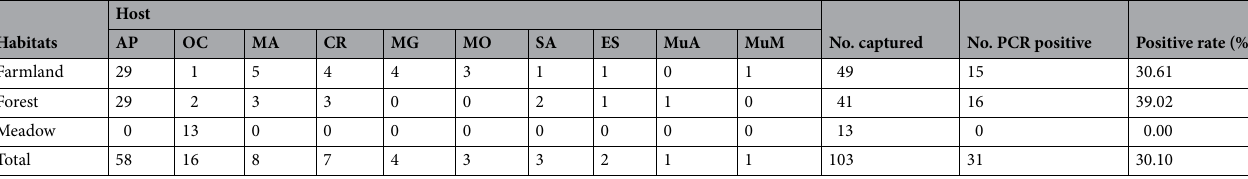
Table 2. Positive rate of Bartonella infection of small mammals in different